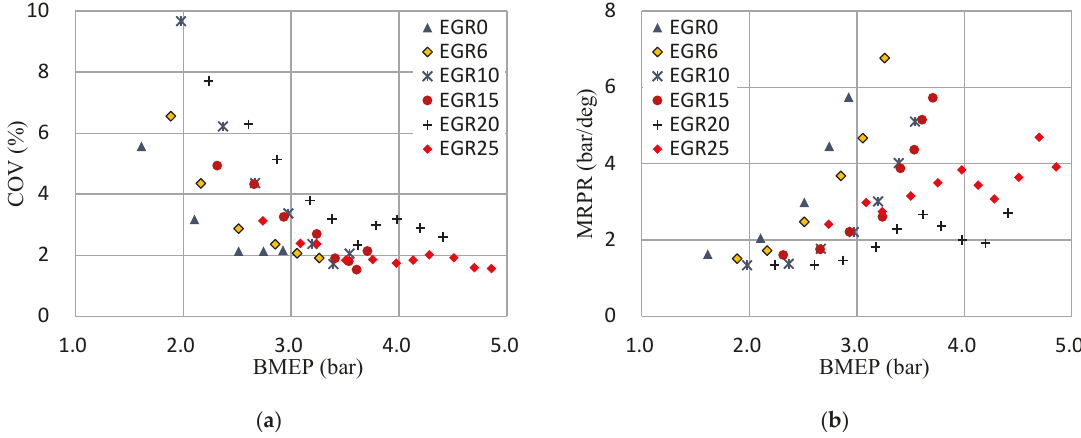
Figure 15. The coefficient of variation of IMEP (COV) and the maximum rate of pressure rise (MRPR) with respect to: ( a ) COV; ( b ) MRPR.